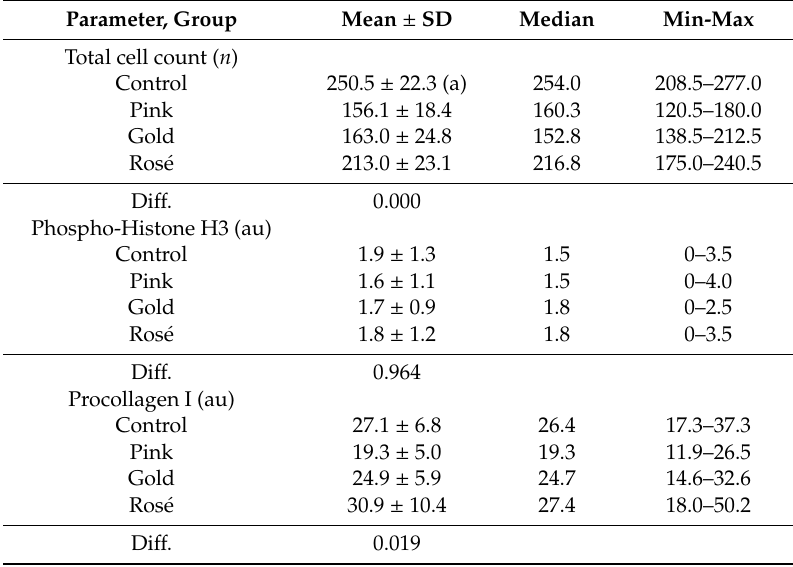
Table 1. Cell growth analysis (as total cell count) and phospho-Histone H3 and procollagen I staining (as mean fluorescence) results for the di ff erent